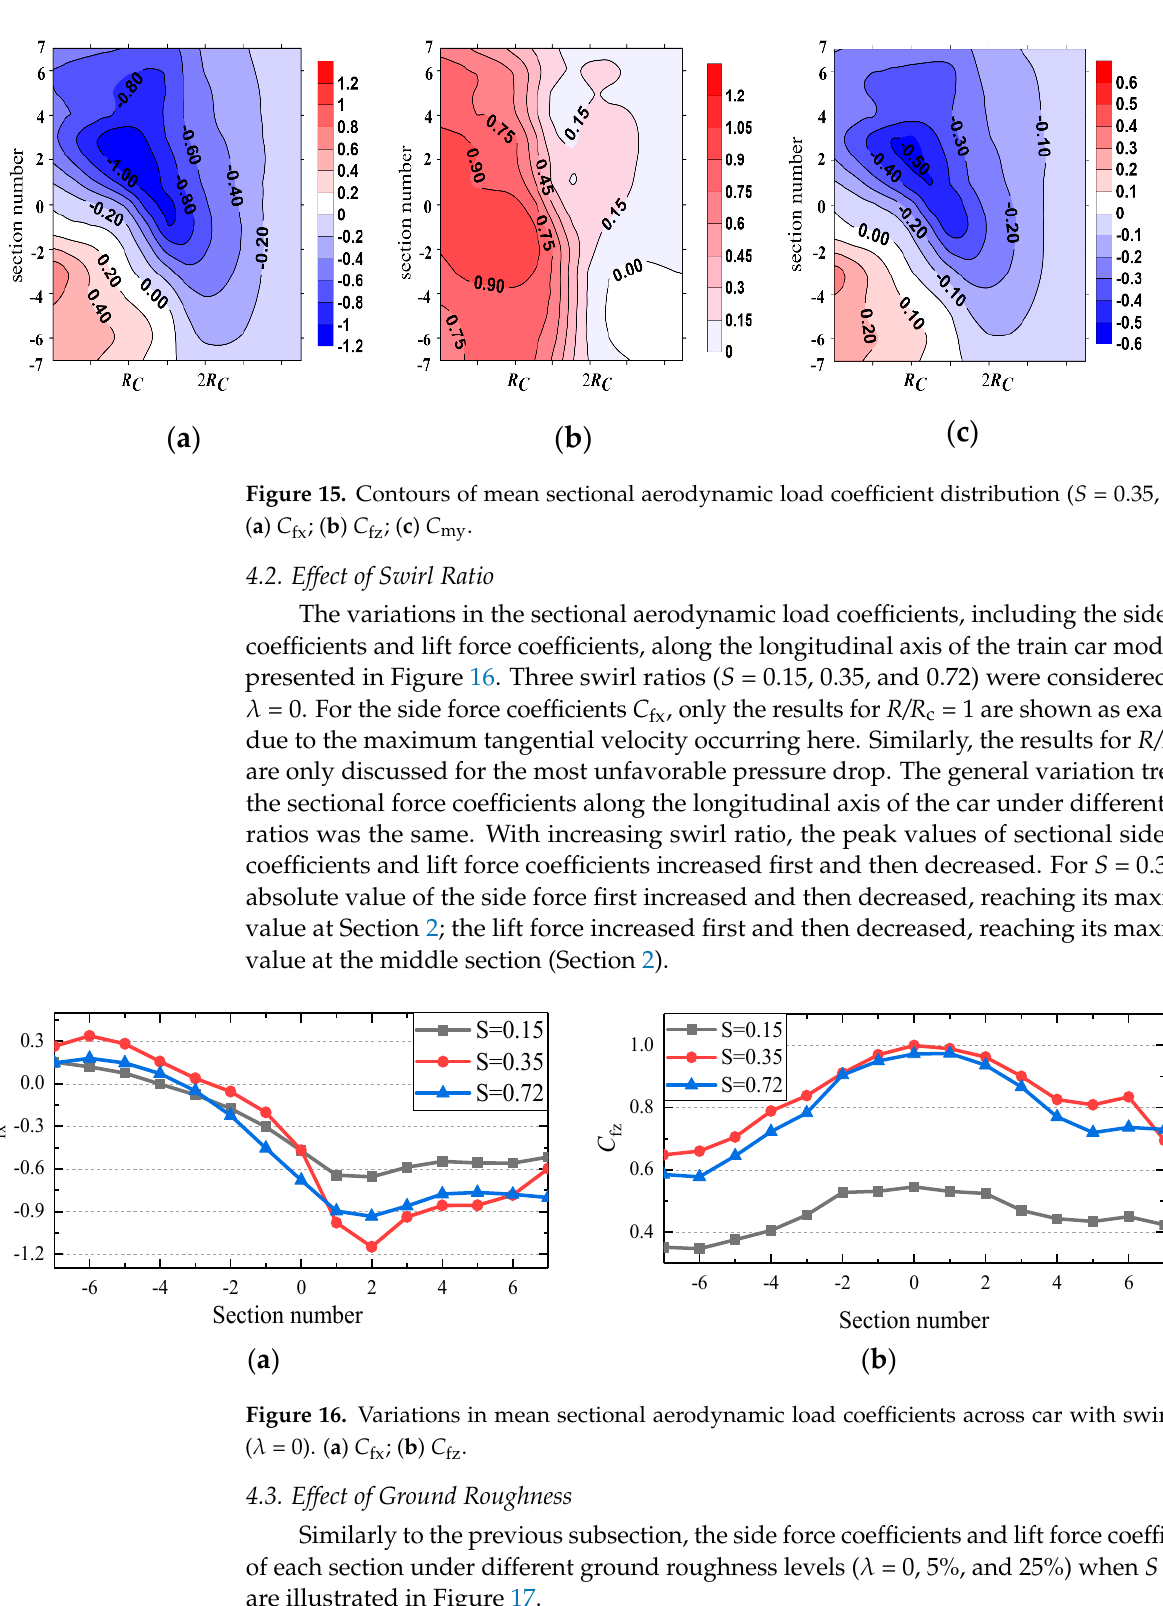
Figure 16. Variations in mean sectional aerodynamic load coefficients across car with swirl ratio ( λ = 0). ( a ) C fx ; ( b ) C fz .